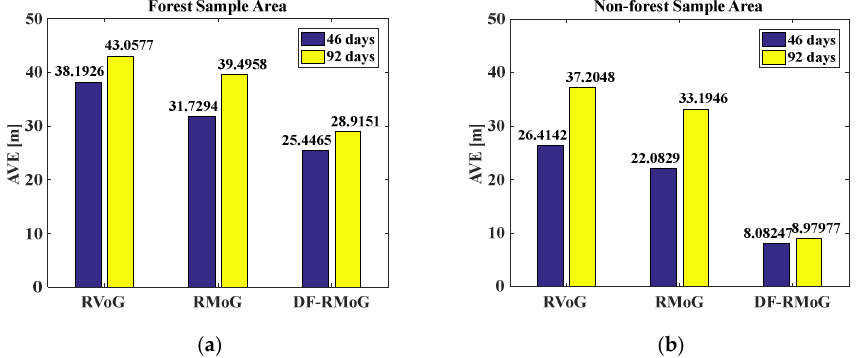
Figure 13. The AVE histogram versus different forest height estimation methods: ( a ) forest sample area. ( b ) non-forest sample area.